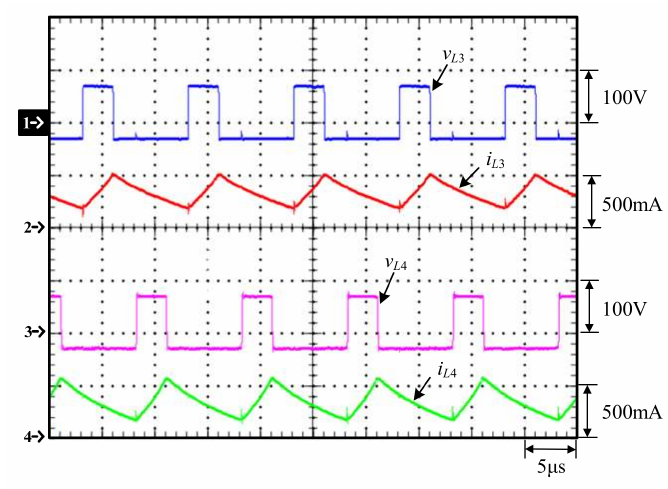
Figure 19. Measured waveforms relevant to rated load: (1) v L 3 ; (2) i L 3 ; (3) v L 4 ; (4) i L 4 .